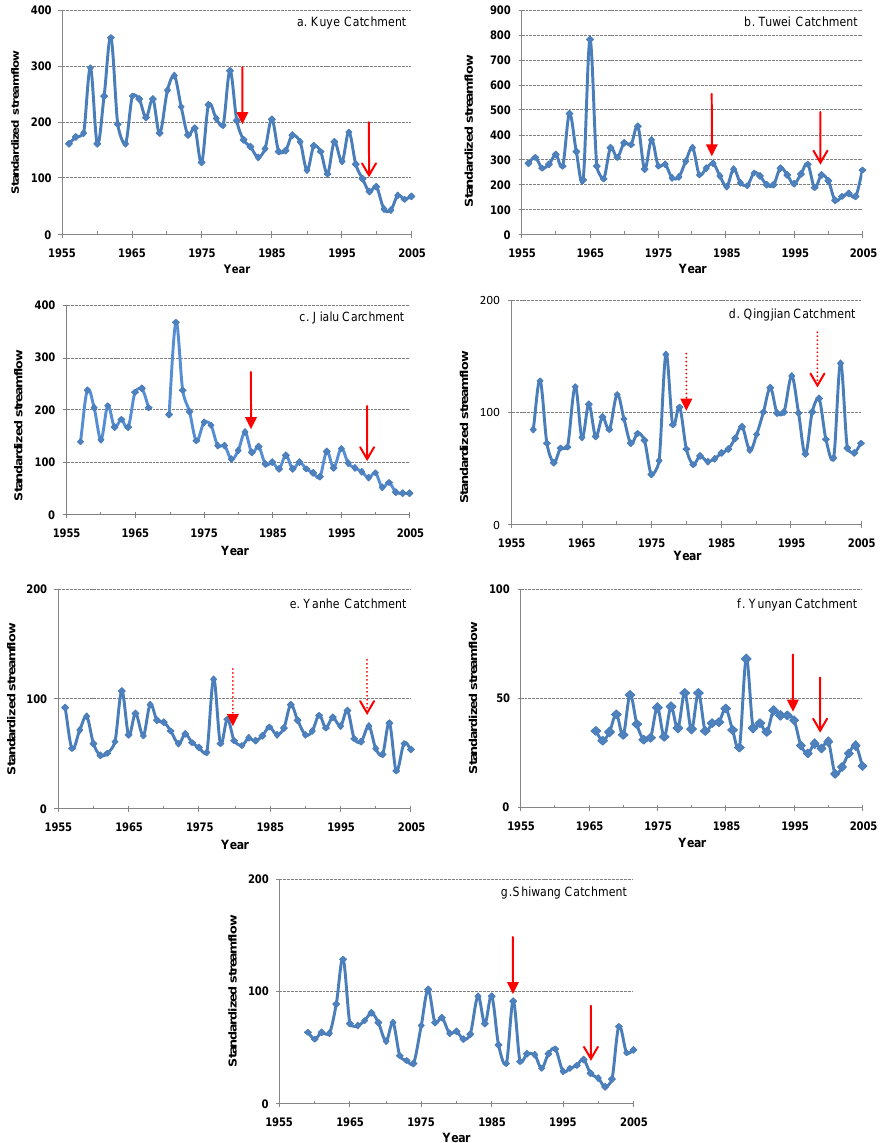
Fig. 2. Standardized annual streamflow with unit m 3 km − 2 mm − 1 in seven catchments. Change points detected with the Pettitt test were marked with 1st solid red arrow in plots (a) , (b) and (c) , three transition zone catchments, and plot (f) and (g) , two rocky mountain catchments. The 2nd red arrow in plots (a – c) and (f – g) signify the year 1999. Change points were given in plot (d) and (e) , two loess hilly gully catchments, see Table 3.